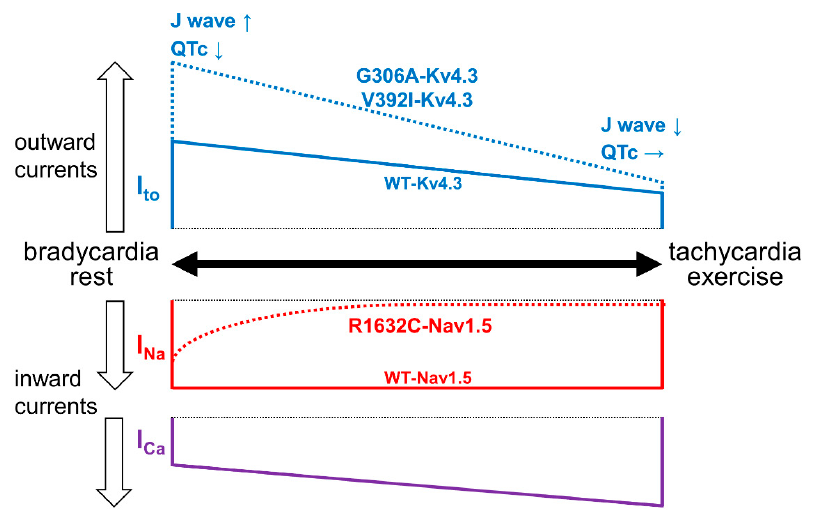
Figure 2. Schematic representation of the heart rate- and physical activity-dependent channel functions of the SCN5A R1632C mutation and KCND3 V392I and G306A mutations. Major ionic currents, I to (blue solid line), I Na (red solid line), and I Ca (purple solid line), during the early phase of AP are shown. Since the SCN5A R1632C mutation induces a marked activity-dependent loss of Nav1.5 availability due to a marked delay of recovery from fast inactivation, R1632C-Nav1.5 markedly decreases during tachycardia/exercise (red dotted line). On the other hand, since the KCND3 V392I and G306A mutations induce an increase of current density and delayed inactivation, V392I-Kv4.3 and G306A-Kv4.3 markedly increase during bradycardia/rest (blue dotted line), while since the KCND3 V392I and G306A mutations induce a marked delay of recovery from inactivation, V392I-Kv4.3 and G306A-Kv4.3 decrease the increased Kv4.3 during tachycardia/exercise (blue dotted line). WT: Wild-type.